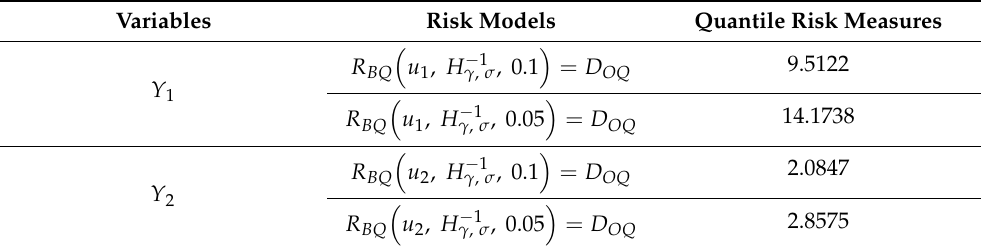
Table 2. Risk measures estimated on the basis of a probabilistic risk model for budget